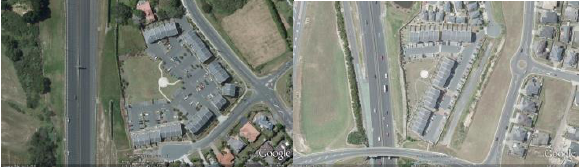
Figure 3. ‘The Ridge’ development (Left) and the ‘Spencer’ (Right) (Source: Google Earth,